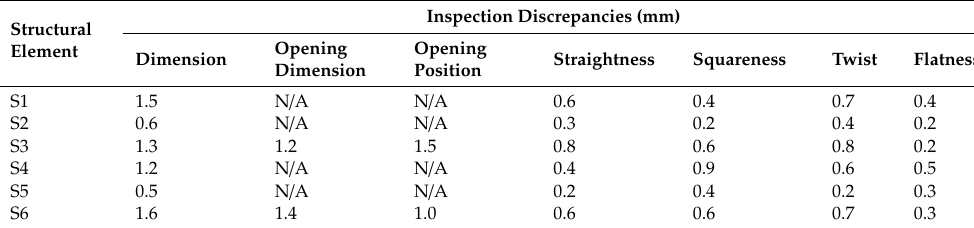
Table 3. Inspection discrepancies between the developed technique and ground truths for the checklist items for structural elements.